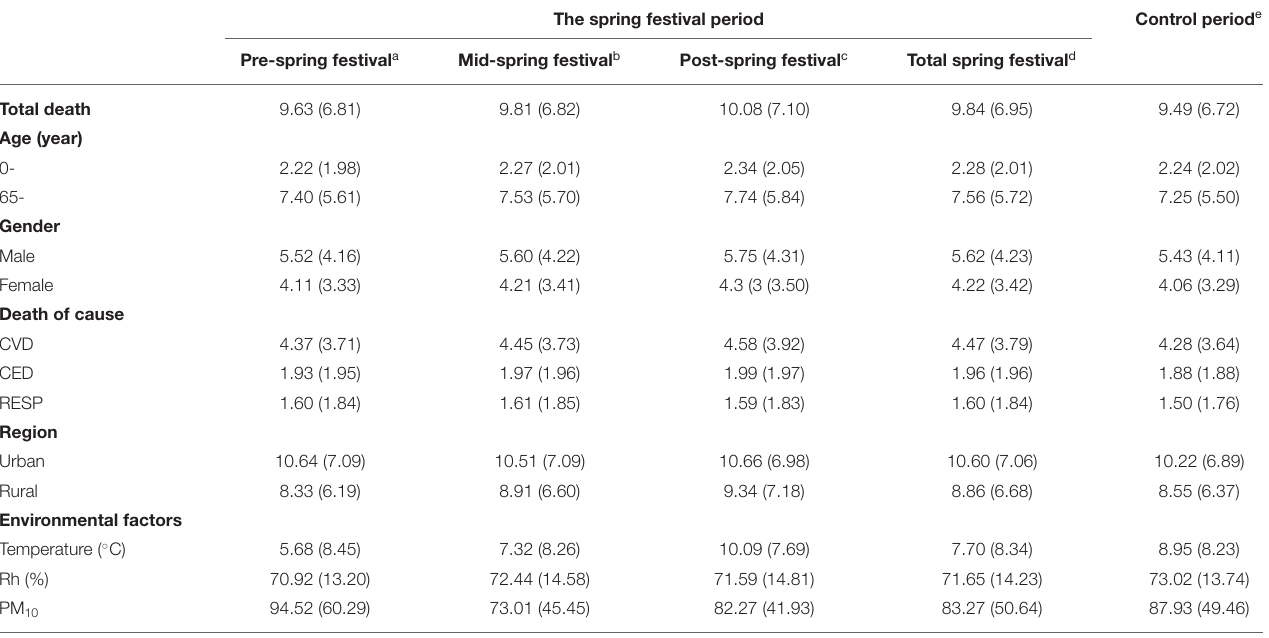
TABLE 1 | The characteristics of mortality and environmental factors during the different parts of the Spring Festival